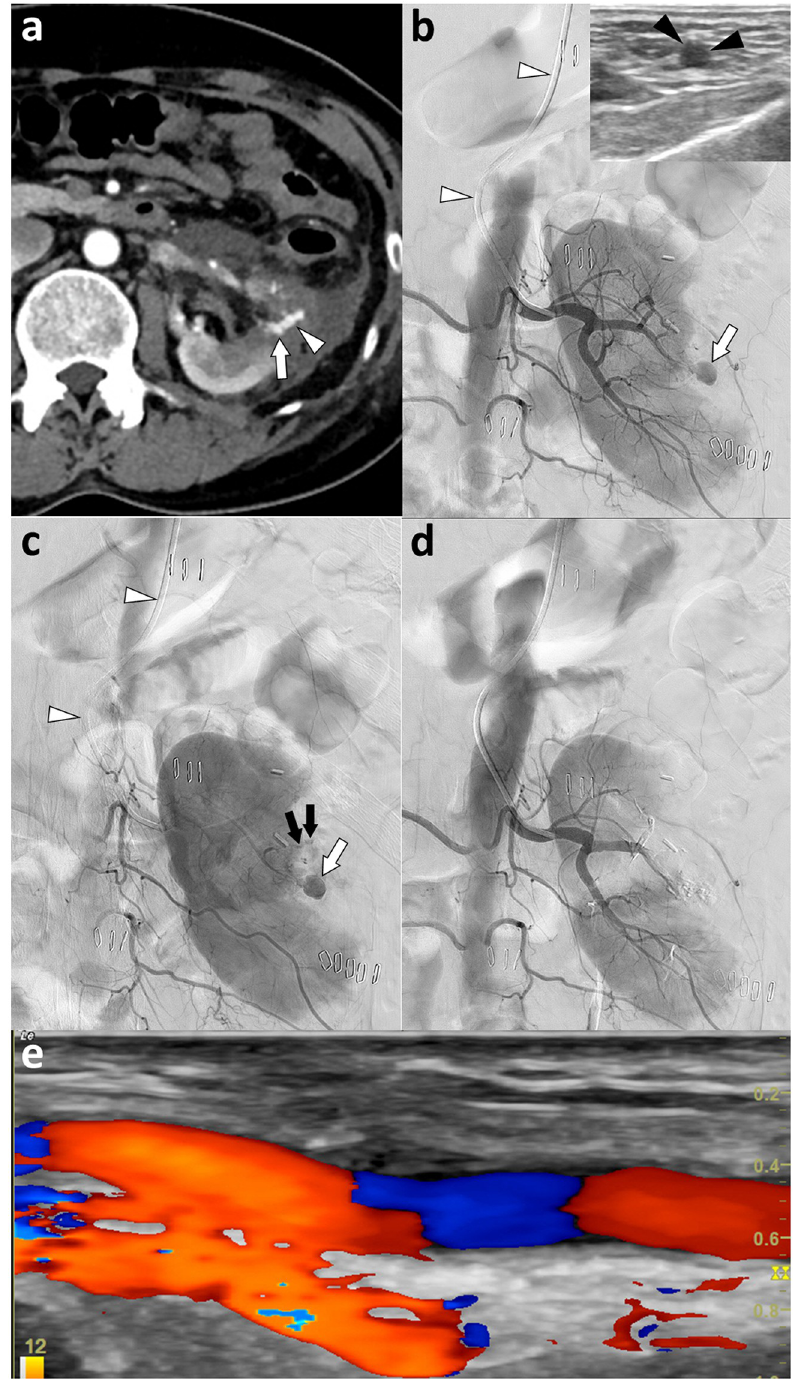
Fig 1. Transradial access for embolization of renal hemorrhage after partial nephrectomy performed 5 days earlier for renal cell carcinoma in a 49-year-old woman. Left radial artery diameter was 2.2 mm, and Barbeau test was type A. (a) Contrast-enhanced CT showing a pseudoaneurysm (arrow) and contrast extravasation (arrowhead). (b and c) Left renal angiograms using a 5-Fr catheter (white arrowheads) showing a pseudoaneurysm (white arrows) and contrast extravasation (black arrows). The left radial artery (black arrowheads) was punctured under ultrasound guidance (inset in B). After superselection of the bleeders with a microcatheter, embolization was performed with n- butyl cyanoacrylate (3:1, oil:NBCA) (not shown) (d) Post-embolization left renal arteriogram showing disappearance of the bleeding focus. The procedure duration was 10 minutes, and the fluoroscopic time was 3.8 minutes. The digital subtraction angiography number was 2, and the dose area product was 8,885 Gy � cm 2 . (e) Four-week follow-up